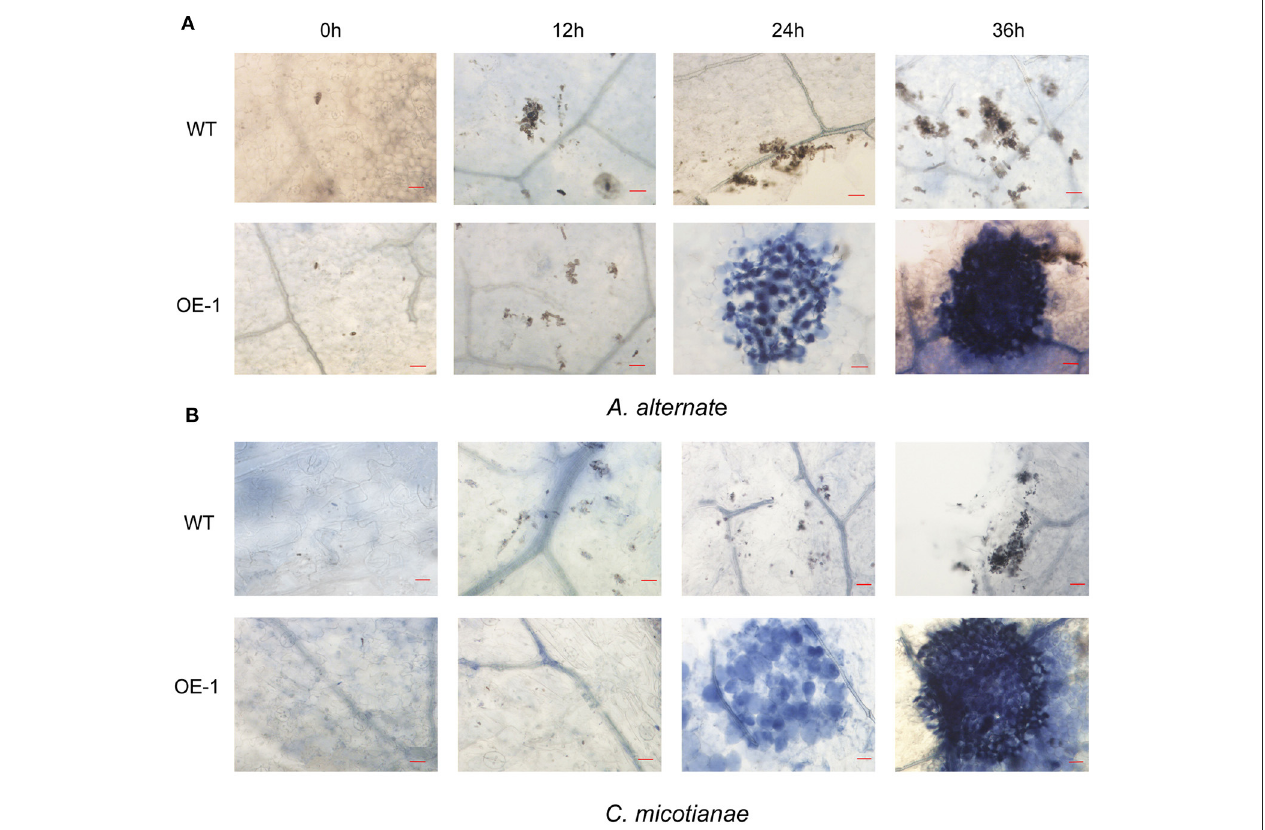
FIGURE 4 | Infection phenotypes of wild-type (WT) and transgenic plant (OE-1) leaves inoculated with fungi. (A) WT and transgenic plants (OE-1) leaves were inoculated with A. alternata (3 × 10 6 spores · ml − 1 ) and stained with trypan blue at 0, 12, 24, 36h to reveal spores, mycelium, and dead plant cells. (B) WT and transgenic plant (OE-1) leaves were inoculated with C. nicotianae Averna (10 6 spores · ml − 1 ) and stained with trypan blue at 0, 12, 24, 36h to reveal spores, mycelium, and dead plant cells. Bar corresponds to 20 µ